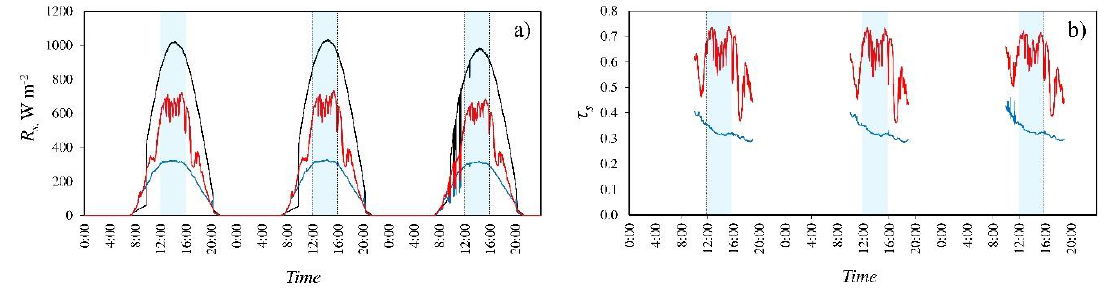
Figure 2. Levels of solar radiation ( a ) and values of transmissivity of the cover to solar radiation ( b ) on 02–04/08/2014. —, exterior; —, sector 1 (without ASP BE ); —, sector 2 (with ASP BE at a concentration of 0.50 kg L − 1 ). Interval of 4 hours around the time when the sun is shining vertically ( ).